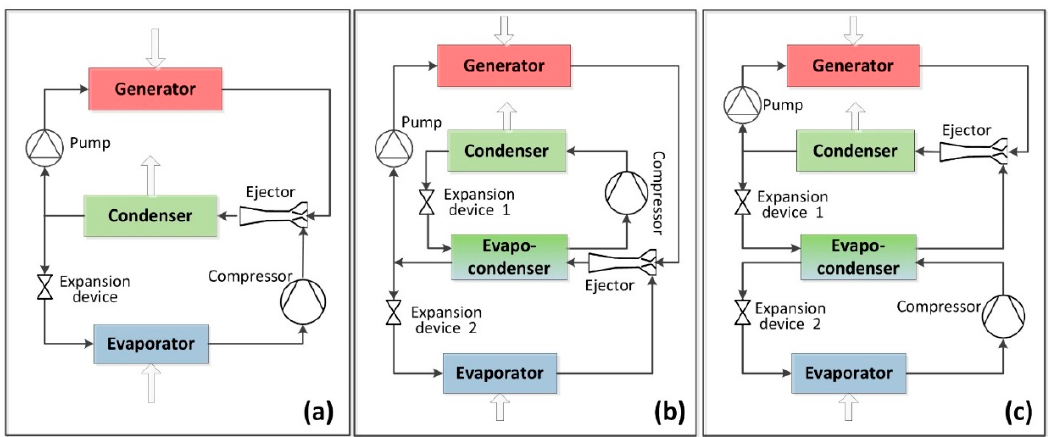
Figure 29. Combined ERS systems analysis: ( a ) hybrid (booster) ejector-compression; ( b ) cascade system I and ( c ) cascade system II [315].